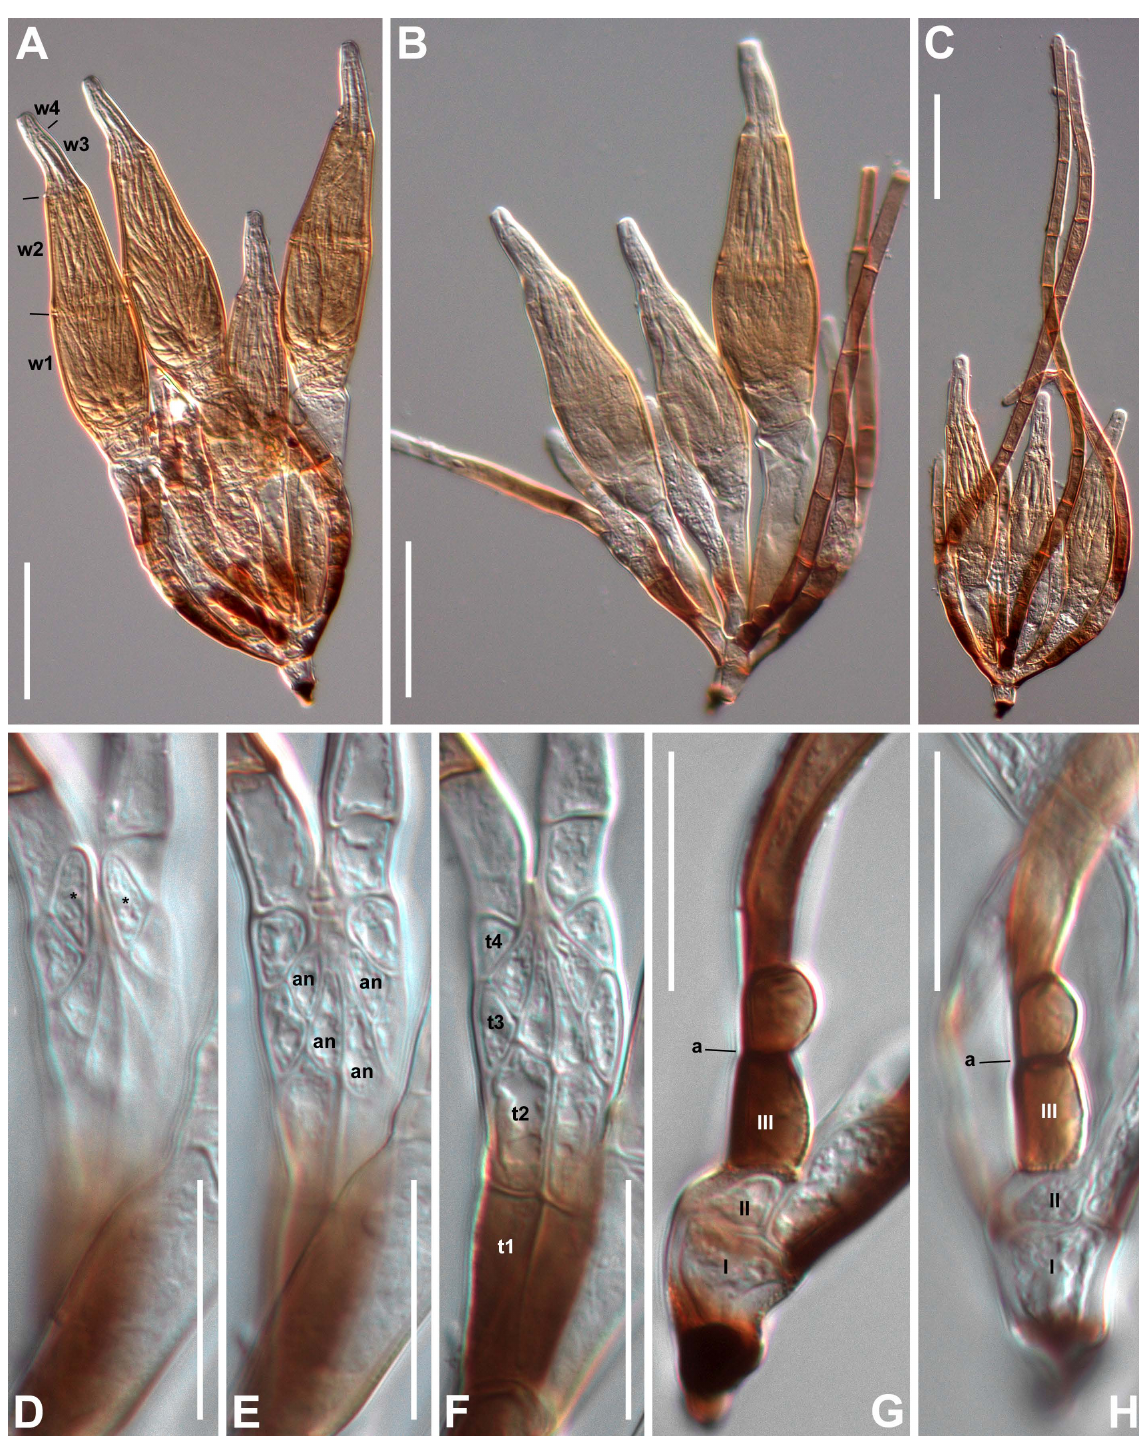
Fig. 84. Monoicomyces crassicaulis Santam. sp. nov. A – C . Mature thalli. In A, perithecial wall cell tiers (w ) have been labelled. D – F . Respectively, near, middle and far focus of antheridium in detail. In E, 1–4 the four phialides have been labelled (an). In F, the four tiers have been labelled (t1–4). G – H . Lower receptacle (I, II, and III) and primary appendage above the primary septum (a) in detail. Scale bars: A–C = 50 µm; D–H = 20 µm. Photographs from slides ZMUC C-F-123576 (A) (holotype), ZMUC C-F-123971 (B), ZMUC C-F-123794